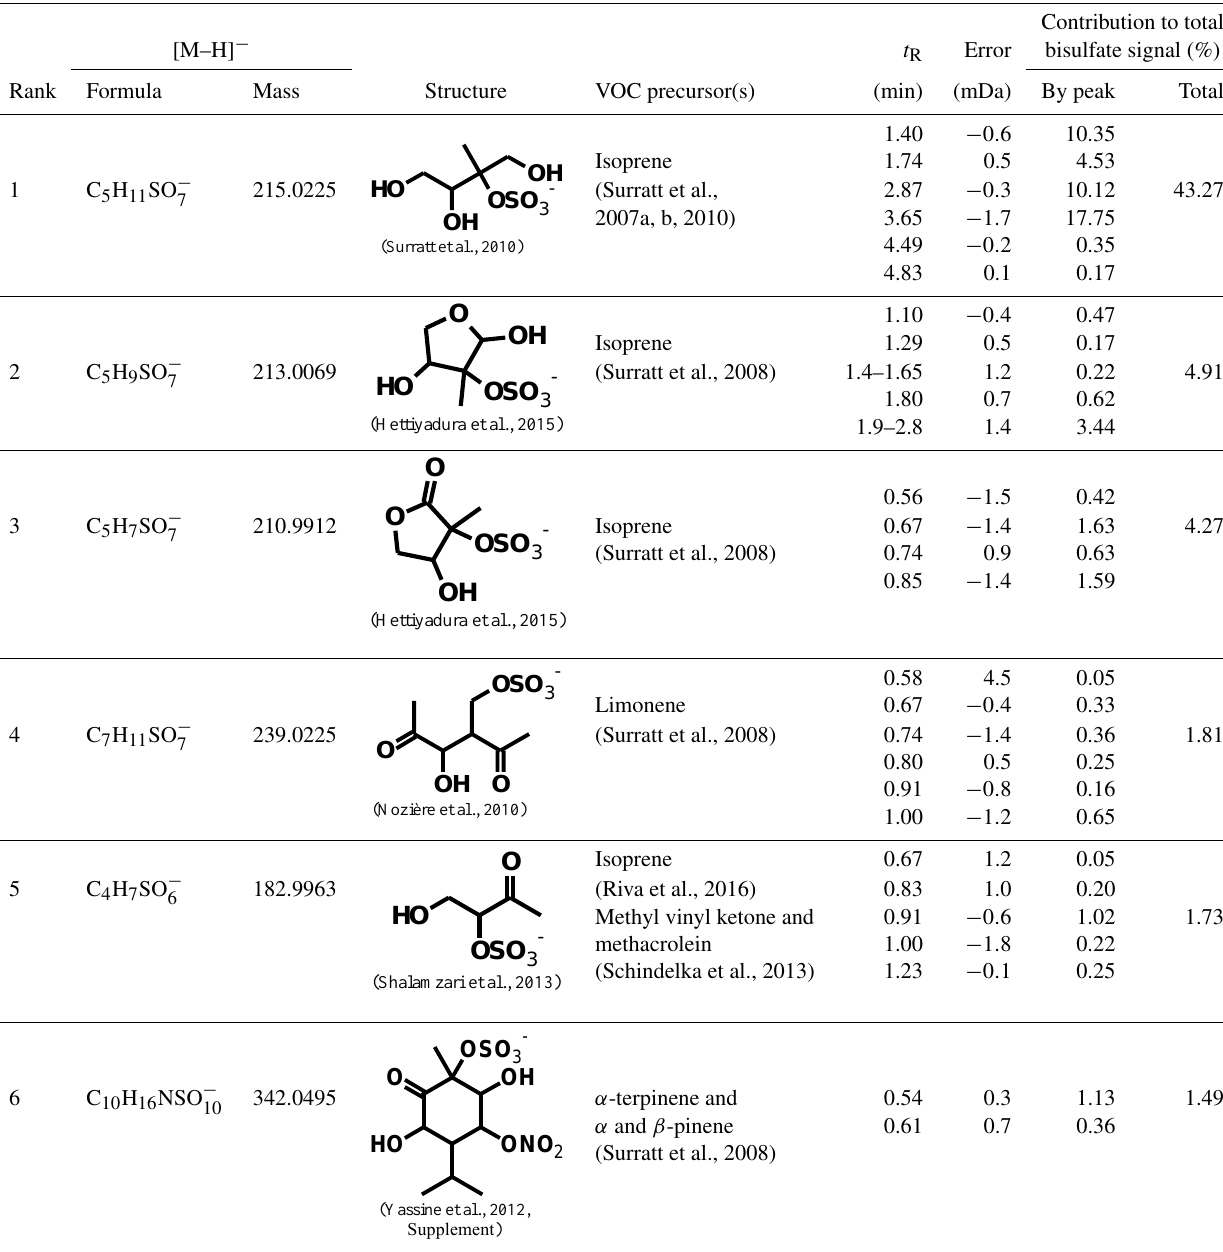
Table 4. The 10 organosulfates with the strongest contributions to the bisulfate product ion signal in Centreville, AL, for the daytime sample collected on 10 July 2013. The 10 organosulfates were ranked in the order of the greatest contribution to the bisulfate product ion signal. Summarized for each signal are formula determined using high resolution TOF–MS, the calculated monoisotopic mass ([M–H] − ) , proposed structure (with reference to the article proposing the structure), VOC precursor(s) indicated by SOA chamber studies, retention time(s) ( t R ) Table 4: The ten organosulfates with the strongest contributions to the bisulfate product ion signal in Centreville, AL for the daytime Table 4: The ten organosulfates with the strongest contributions to the bisulfate product ion signal in Centreville, AL for the daytime on the BEH-amide column during HILIC gradient separation (solvent peak at 0.38min), error in m/z (mDa) for each peak, and the relative Table 4: The ten organosulfates with the strongest contributions to the bisulfate product ion signal in Centreville, AL for the daytime sample collected on 10 July 2013. The ten organosulfates were ranked in the order of the greatest contribution to the bisulfate product ion sample collected on 10 July 2013. The ten organosulfates were ranked in the order of the greatest contribution to the bisulfate product ion sample collected on 10 July 2013. The ten organosulfates were ranked in the order of the greatest contribution to the bisulfate product ion contribution of each peak and the total peak area to the total bisulfate product ion signal. Many organosulfates are likely to have multiple signal. Summarized for each signal are formula determined using high resolution ToF MS, the calculated monoisotopic mass ([M-H] - ), signal. Summarized for each signal are formula determined using high resolution ToF MS, the calculated monoisotopic mass ([M-H] - ), Table 4: The ten organosulfates with the strongest contributions to the bisulfate product ion signal in Centreville, AL for the daytime signal. Summarized for each signal are formula determined using high resolution ToF MS, the calculated monoisotopic mass ([M-H] - ), proposed structure (with reference to the article proposing the structure), VOC precursor(s) indicated by SOA chamber studies, retention isomers, although only one isomer is shown. proposed structure (with reference to the article proposing the structure), VOC precursor(s) indicated by SOA chamber studies, retention sample collected on 10 July 2013. The ten organosulfates were ranked in the order of the greatest contribution to the bisulfate product ion proposed structure (with reference to the article proposing the structure), VOC precursor(s) indicated by SOA chamber studies, retention time(s) (t R ) on the BEH-amide column during HILIC gradient separation (solvent peak at 0.38 min), error in m/z (mDa) for each peak, and 5 Table 4: The ten organosulfates with the strongest contributions to the bisulfate product ion signal in Centreville, AL for the daytime time(s) (t R ) on the BEH-amide column during HILIC gradient separation (solvent peak at 0.38 min), error in m/z (mDa) for each peak, and 5 signal. Summarized for each signal are formula determined using high resolution ToF MS, the calculated monoisotopic mass ([M-H] - ), time(s) (t R ) on the BEH-amide column during HILIC gradient separation (solvent peak at 0.38 min), error in m/z (mDa) for each peak, and 5 the relative contribution of each peak and the total peak area to the total bisulfate product ion signal. Many organosulfates are likely to sample collected on 10 July 2013. The ten organosulfates were ranked in the order of the greatest contribution to the bisulfate product ion the relative contribution of each peak and the total peak area to the total bisulfate product ion signal. Many organosulfates are likely to proposed structure (with reference to the article proposing the structure), VOC precursor(s) indicated by SOA chamber studies, retention the relative contribution of each peak and the total peak area to the total bisulfate product ion signal. Many organosulfates are likely to have multiple isomers, although only one isomer is shown. signal. Summarized for each signal are formula determined using high resolution ToF MS, the calculated monoisotopic mass ([M-H] - ), have multiple isomers, although only one isomer is shown. time(s) (t R ) on the BEH-amide column during HILIC gradient separation (solvent peak at 0.38 min), error in m/z (mDa) for each peak, and 5 have multiple isomers, although only one isomer is shown. proposed structure (with reference to the article proposing the structure), VOC precursor(s) indicated by SOA chamber studies, retention the relative contribution of each peak and the total peak area to the total bisulfate product ion signal. Many organosulfates are likely to time(s) (t R ) on the BEH-amide column during HILIC gradient separation (solvent peak at 0.38 min), error in m/z (mDa) for each peak, and 5 have multiple isomers, although only one isomer is shown. the relative contribution of each peak and the total peak area to the total bisulfate product ion signal. Many organosulfates are likely to have multiple isomers, although only one isomer is shown.